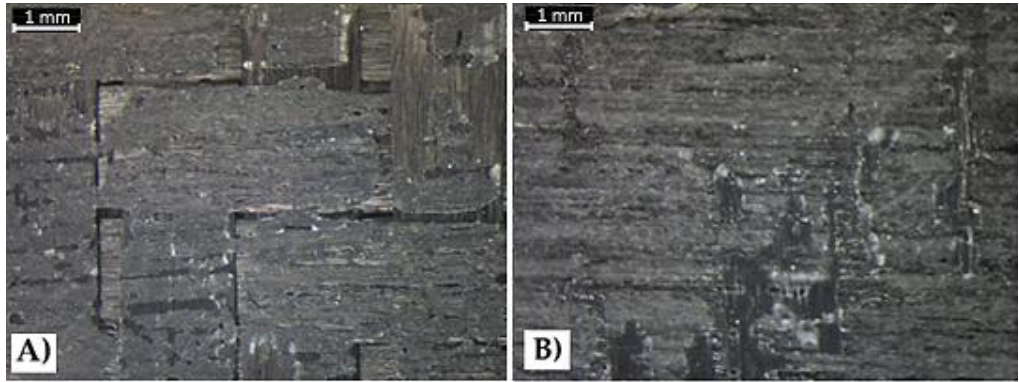
Figure 9. Optical microscope observations of the fracture surfaces of ( A ) CFRP and ( B ) PA12-CR of EP_P_1L specimen after DCB test.